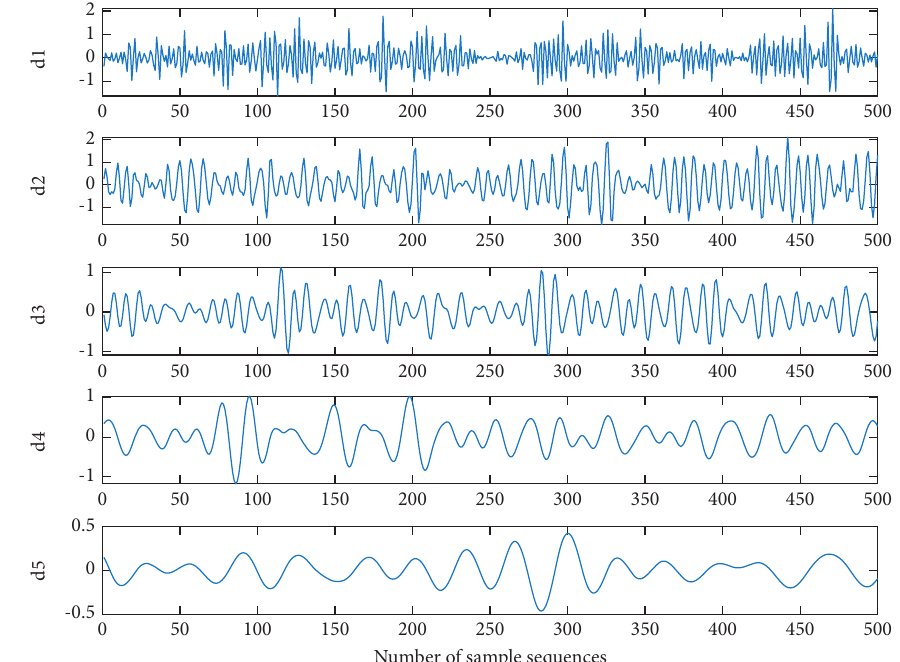
Figure 14: Wavelet decomposition chart of bearing’s inner race at